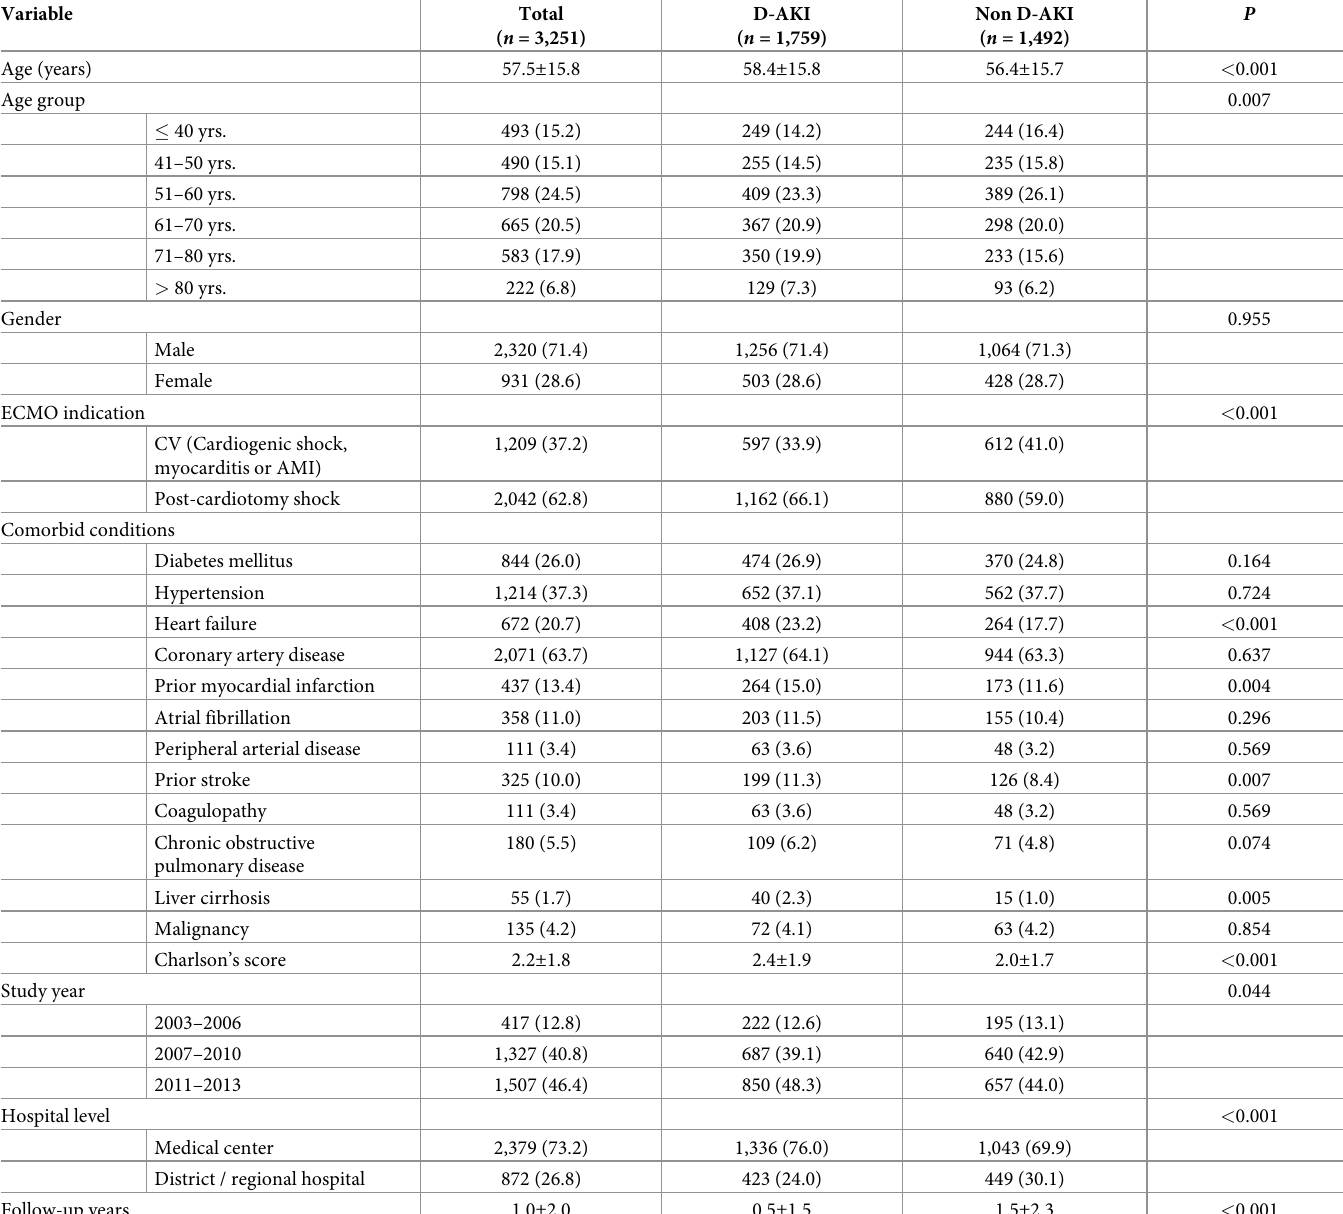
Table 1. Demographic and clinical characteristics of the study